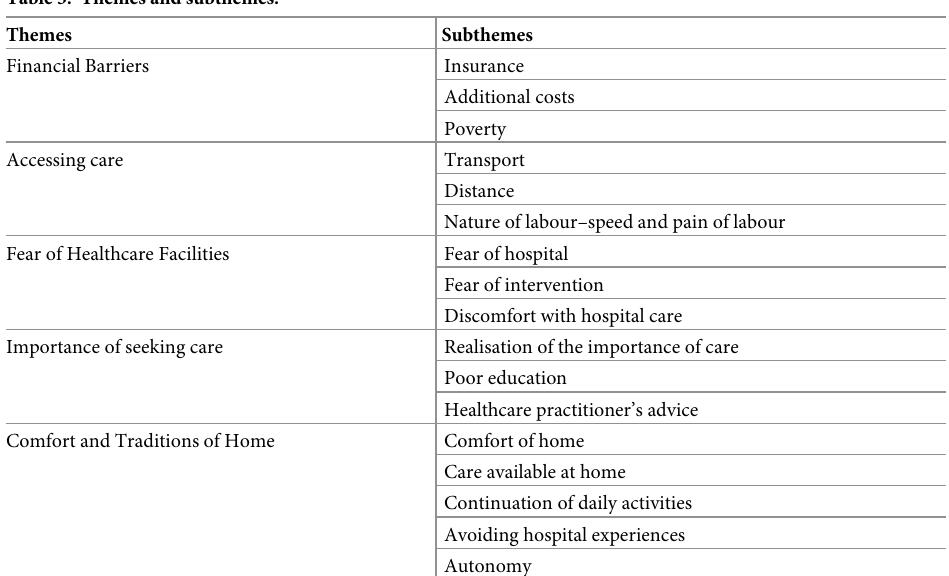
Table 3. Themes and